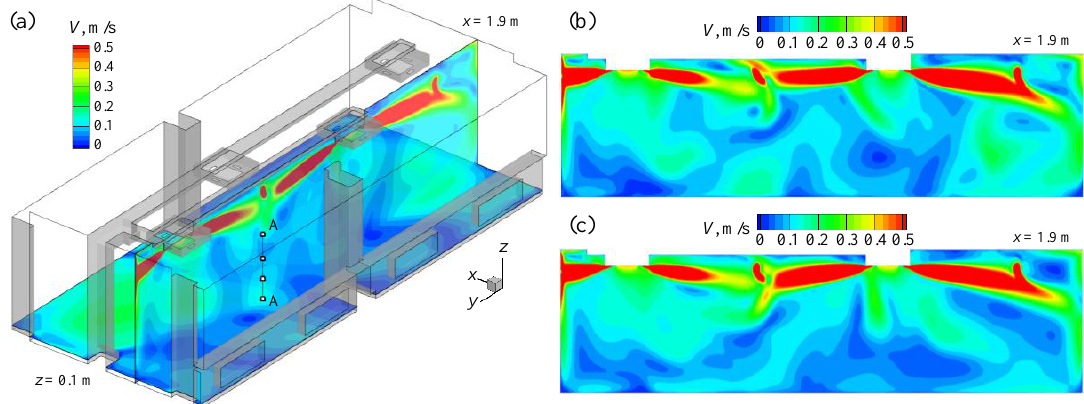
Figure 5. Instantaneous velocity magnitude at various cross-sections in two moments of time: ( a ), ( b ) t = t 0 and ( c ) t = t 0 + 5000 s (data for θ = 25°, case #2). The vertical section, chosen for post-processing, crosses fan coil #2 (the right part of the plot) and fan coil #4 (the left part of the plot), and demonstrates the flow structure only partially. Even at this